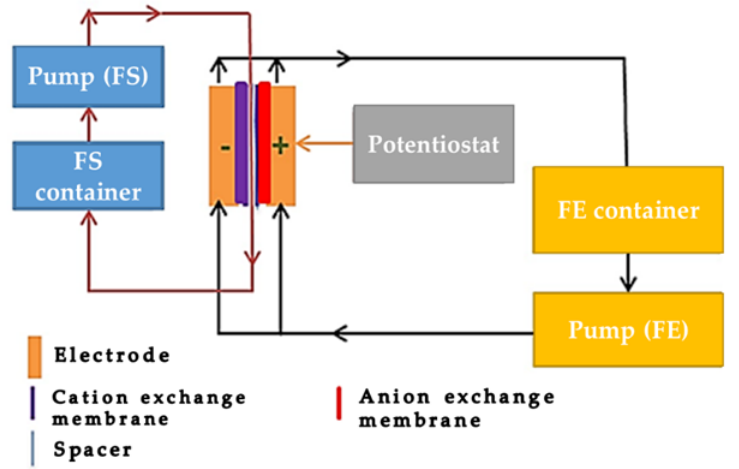
Figure 1. Schematic diagram of FCDI setup is a figure.